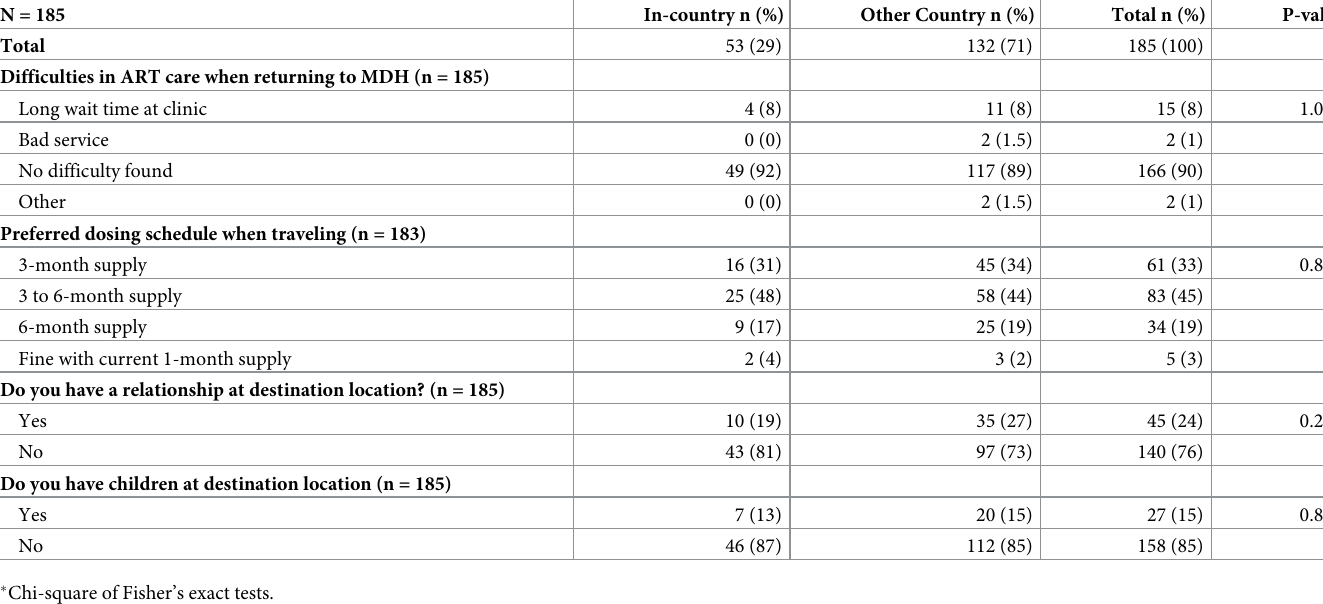
Table 3. Self-reported perceptions of mobile HIV-positive adults about their HIV care by those who migrate within Mozambique versus outside of Mozambique.